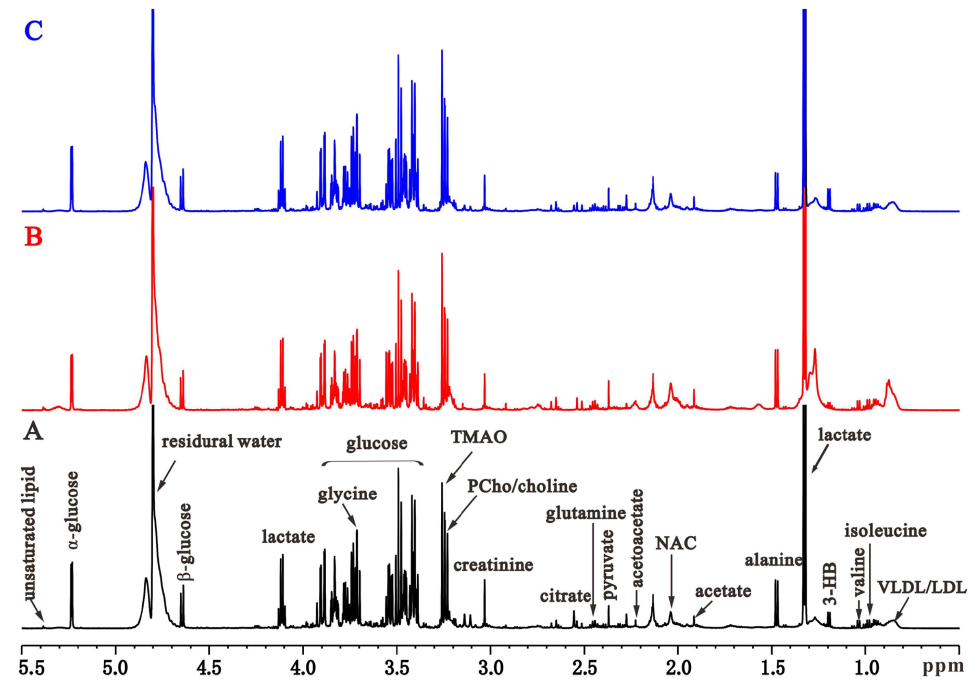
Figure 2. Representative 1 H CPMG spectra of serum obtained from the SO (A), UUO (B) and CAO (C) rats on day 7, respectively. NAC, N-acetylglycoproteins; TMAO, trimethylamine-N-oxide; 3-HB, 3-hydrobutyrate.